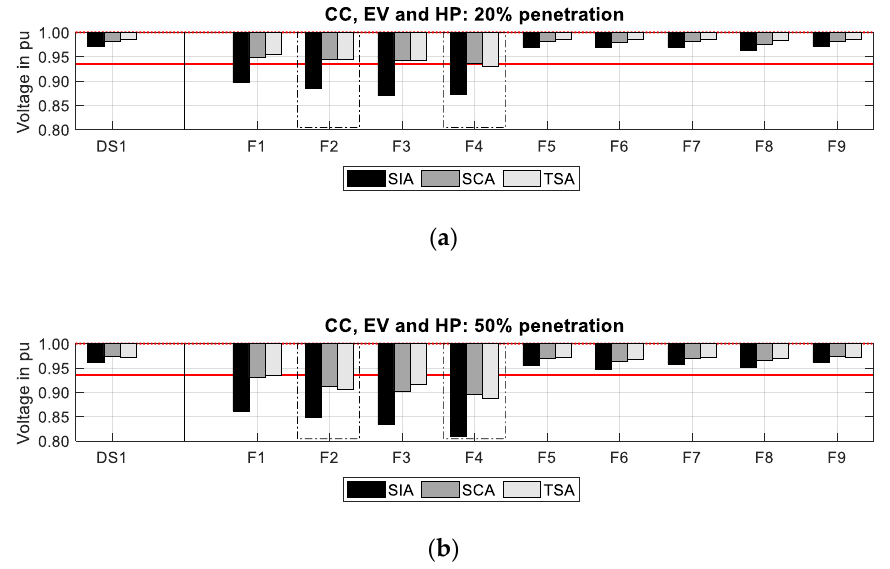
Figure 12. Comparison of various load approaches regarding voltage deviations at the distribution substation (DS1) as well as at feeders (F1–F9) considering an EV- and HP-penetration of 20% ( a ) and 50% ( b ) supplied by the suburban LV grid.